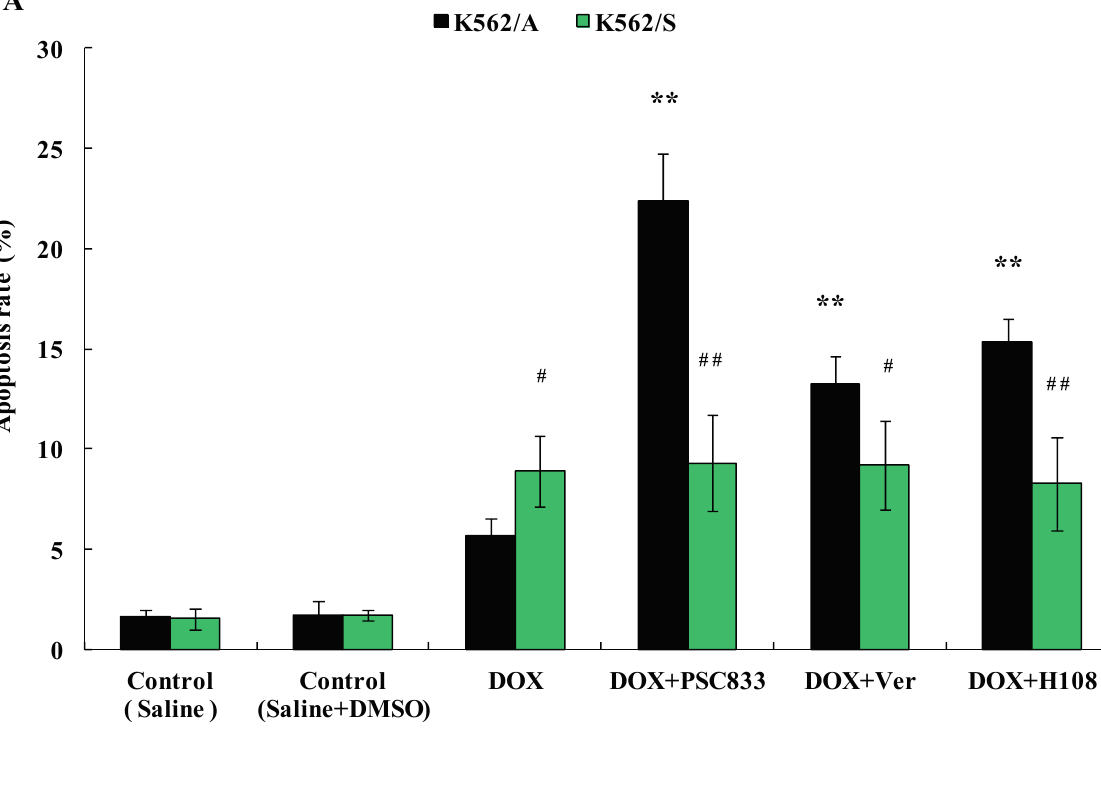
Figure 2. Apoptosis of K562/A and K562/S cells induced by Dox and effects of P-gp inhibitors. Both cell lines were incubated at the IC value of Dox (8.11 µM for K562/A 30 and 0.016 µM for K562/S), some groups combined PSC833 (0.1 µM), Ver (5 µM) or H108 (5 µM), with Dox for 24 h. ( A ) Apoptotic rate of K562/A and K562/S cells determined by flow cytometry analysis. ( B ) Caspase 3 activity measured by immunoassay. ( C ) Cell cycle of K562/A and K562/S cells determined by flow cytometry analysis. Data are shown as mean ± SD. Student’s t-test ( n = 6). * p < 0.05, ** p < 0.01 comparing with model